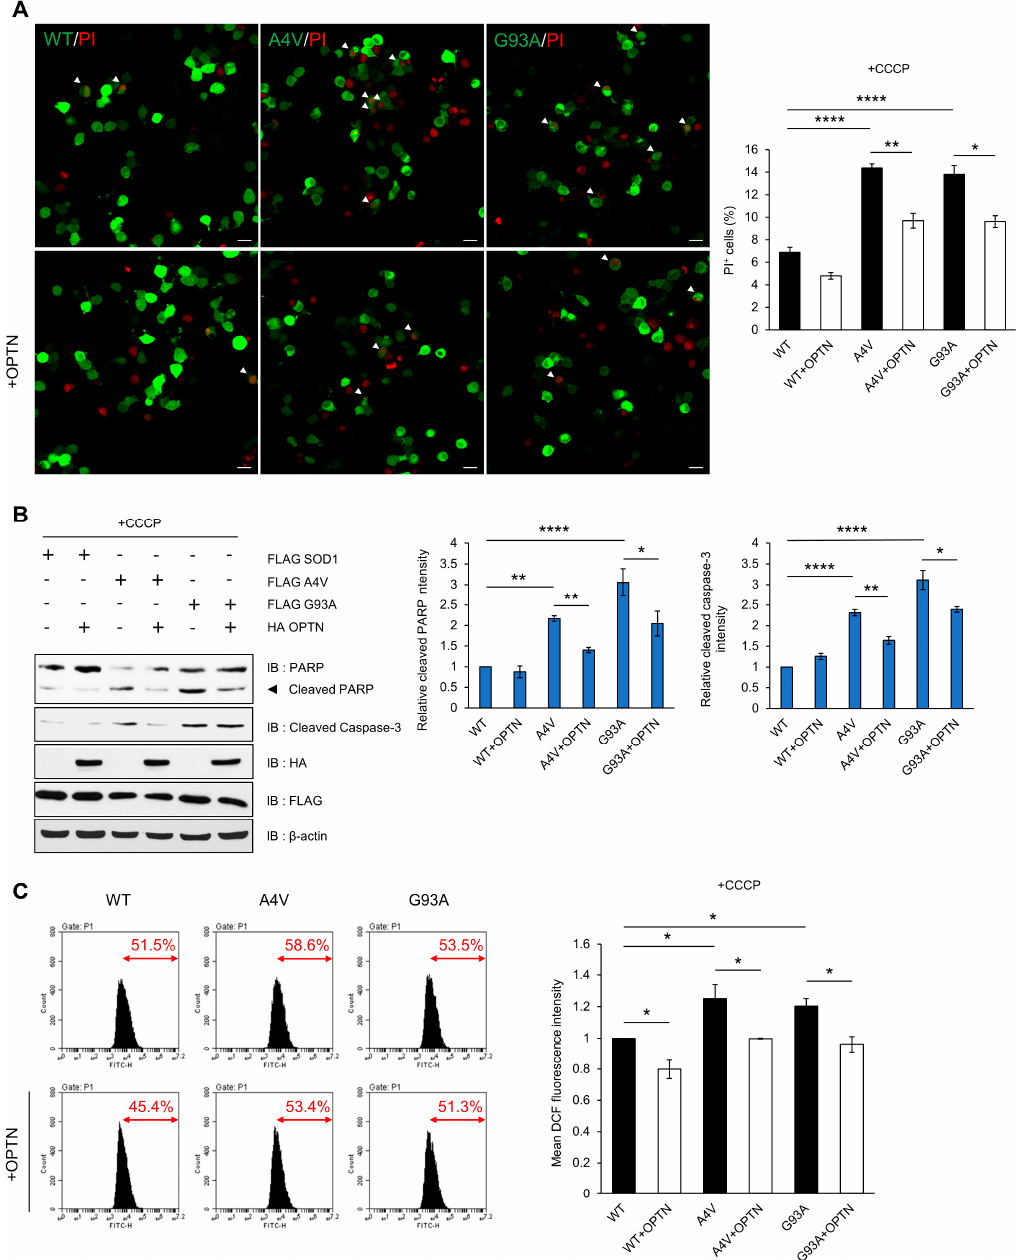
Figure 5. Over-expression of OPTN reduces cytotoxicity induced by mutant SOD1. N2a cells were transiently transfected with FLAG-tagged wild type SOD1 or mutant SOD1 (A4V and G93A) for 48 h. ( A ) Applied post transfection, the PI stained nuclei identifies dead cells. The cell death ratio was measured as the percentage of SOD1-GFP transfected cells exhibiting PI + staining (white arrows). Scale bar = 20 µ M. ( B ) For the validation of cell death, cell lysates were analyzed by immunoblot with antibodies to PARP and caspase-3. ( C ) Intracellular ROS production was measured by DCF fluorescence and analyzed by flow cytometry after CCCP treatment (10 uM, 12 h). The data are means ± SEM from three independent experiments. * p < 0.05; ** p < 0.01; **** p < 0.0001.